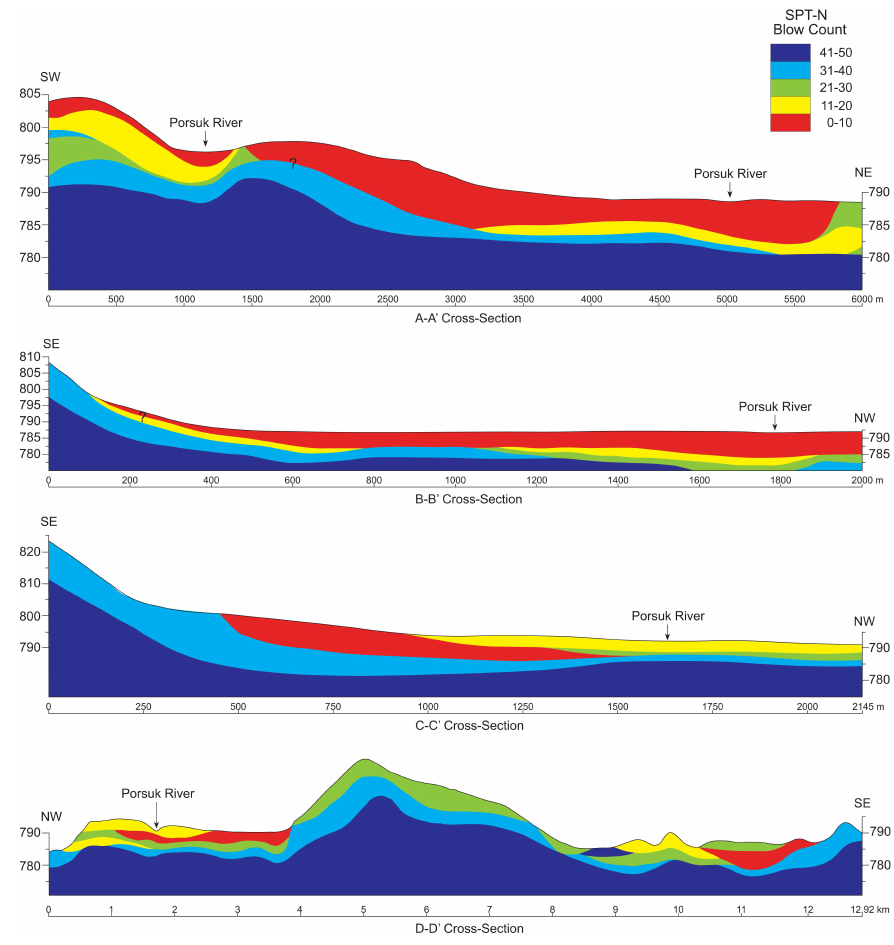
Fig. 6. Distribution of SPT-N blow counts for different